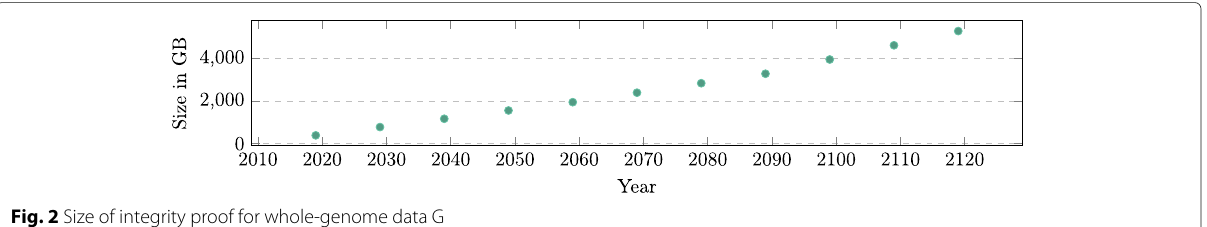
Fig. 2 Size of integrity proof for whole-genome data